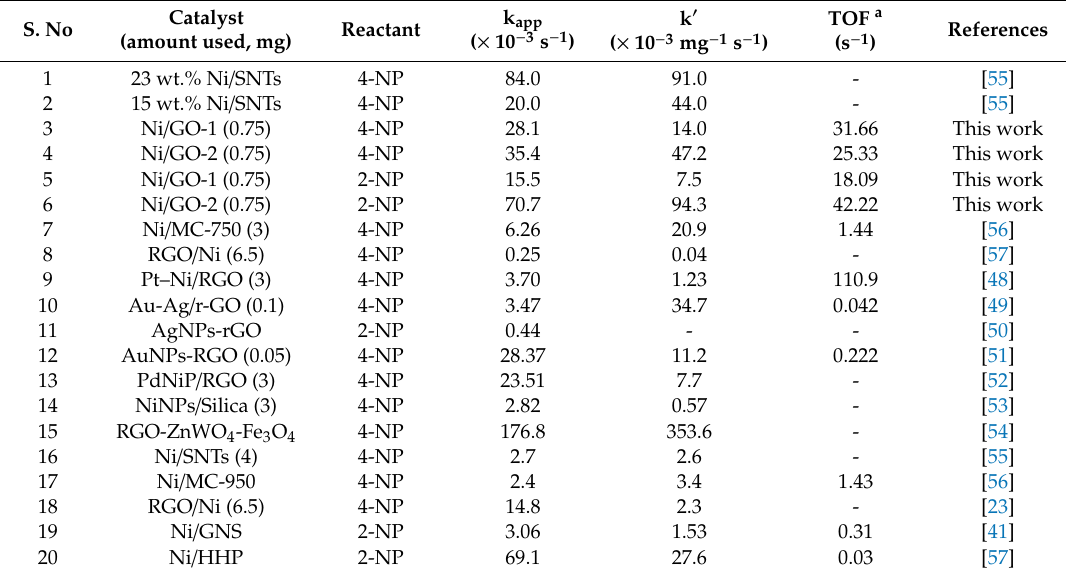
Table 1. Comparison of present Ni / GO nanocomposites over other heterogeneous catalysts.